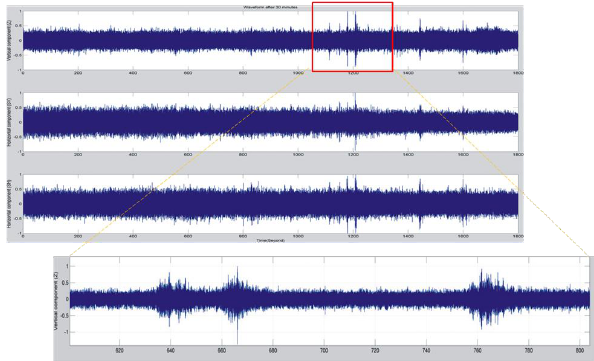
Fig. 2. Thirty minutes of the recorded time series data. The zoomed- Figure 2. Thirty minutes of the recorded time series data. The zoomed-in part of the vertical 3 in part of the vertical component data shows larger amplitude as component data shows larger amplitude as well as discontinuities. 4 well as discontinuities.